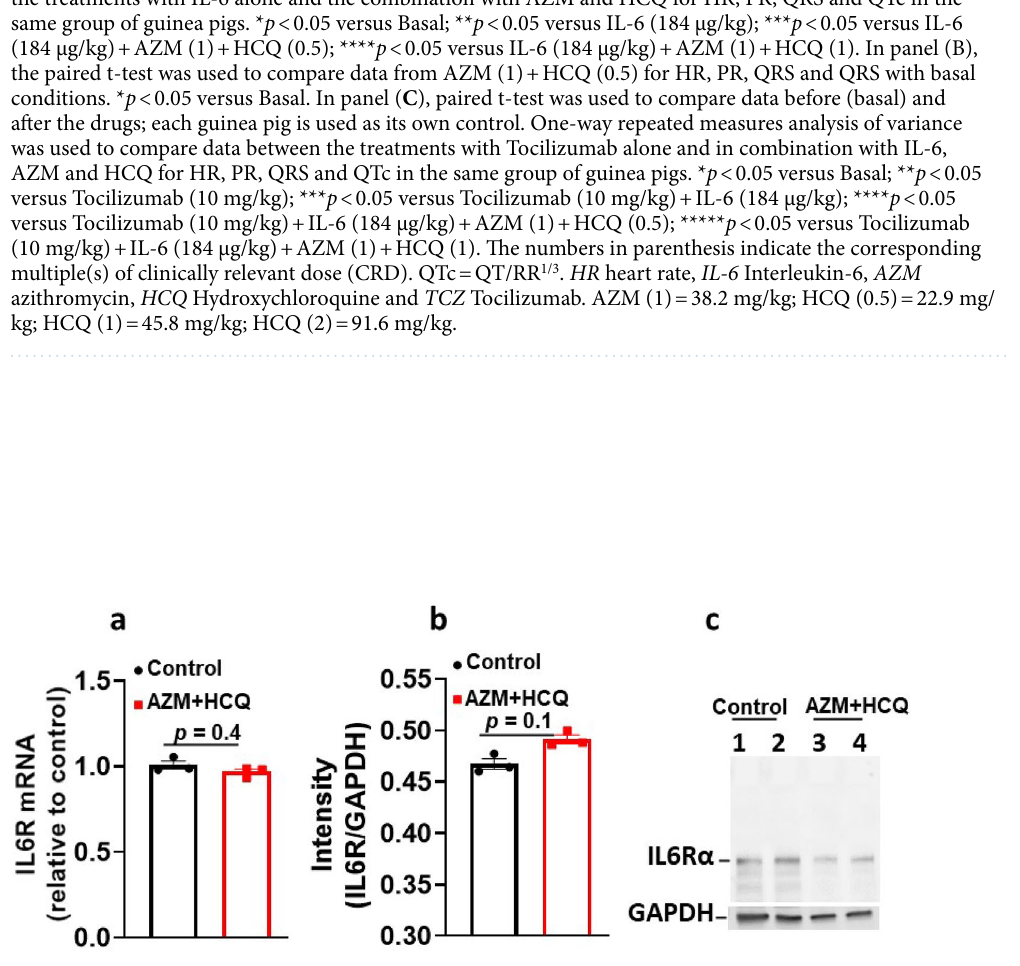
was used to compare data between the treatments with Tocilizumab alone and in combination with IL-6, AZM and HCQ for HR, PR, QRS and QTc in the same group of guinea pigs. * p < 0.05 versus Basal; ** p < 0.05